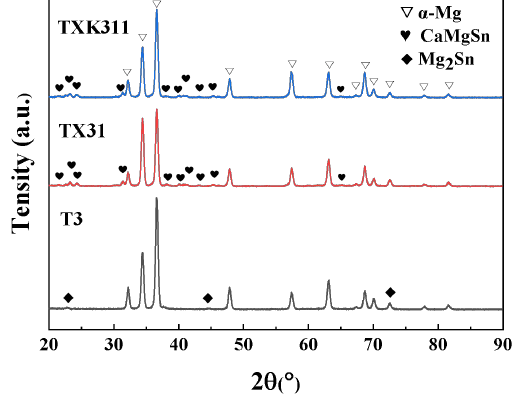
Figure 2. XRD patterns of as-extruded T3, TX31 and TXK311 alloys Figure 3. XRD patterns of as-extruded T3, TX31, and TXK311